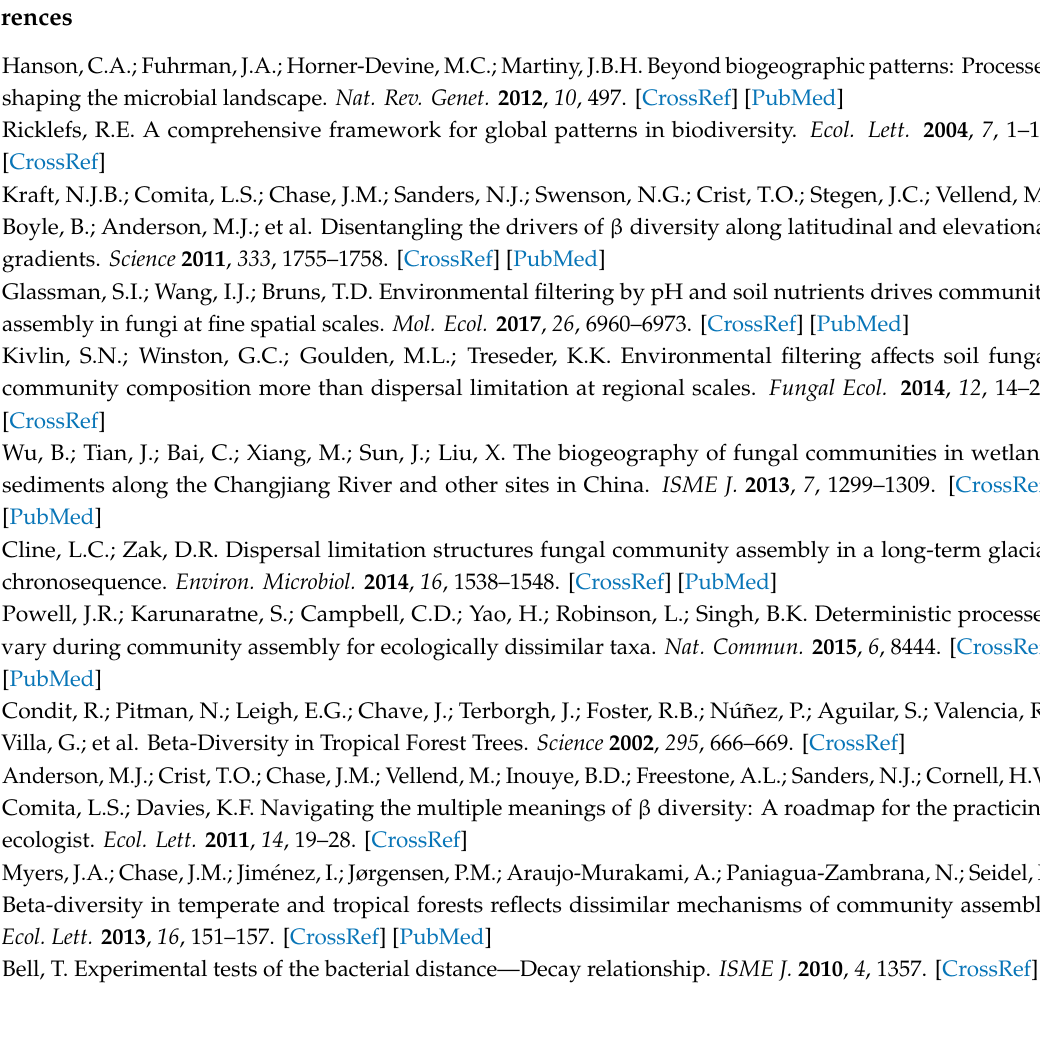
Table S1: The dominant soil fungal phyla across the sampling